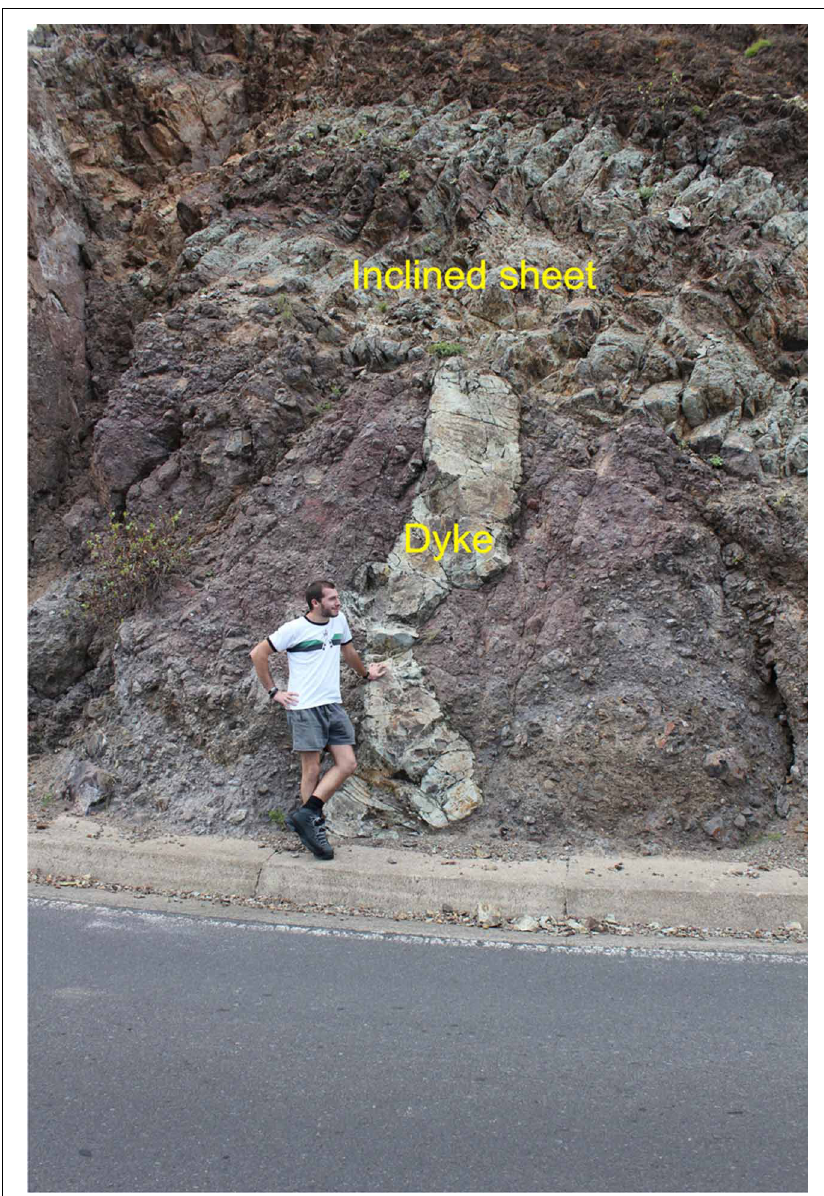
FIGURE 5 | Dyke propagation. Dyke paths are complex and cannot, at this stage of theoretical understanding, be reliably forecasted during unrest periods in volcanoes. Many dykes become arrested, particularly at contacts between mechanically dissimilar rocks, like this basaltic dyke in Tenerife (Canary Islands). The soft rock hosting the dyke is altered breccia, whereas the stiff rock arresting the dyke is an older, inclined